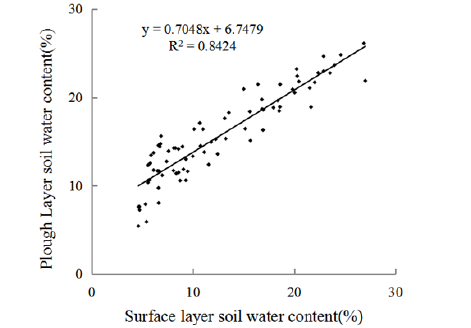
Figure 3. Relationship between surface soil and cultivated soil water